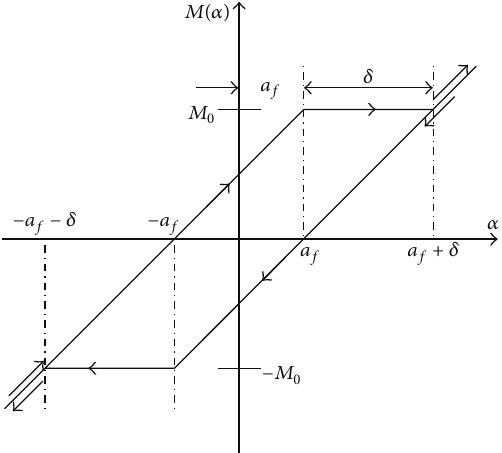
Figure 2: General sketch of hysteresis stiffness.